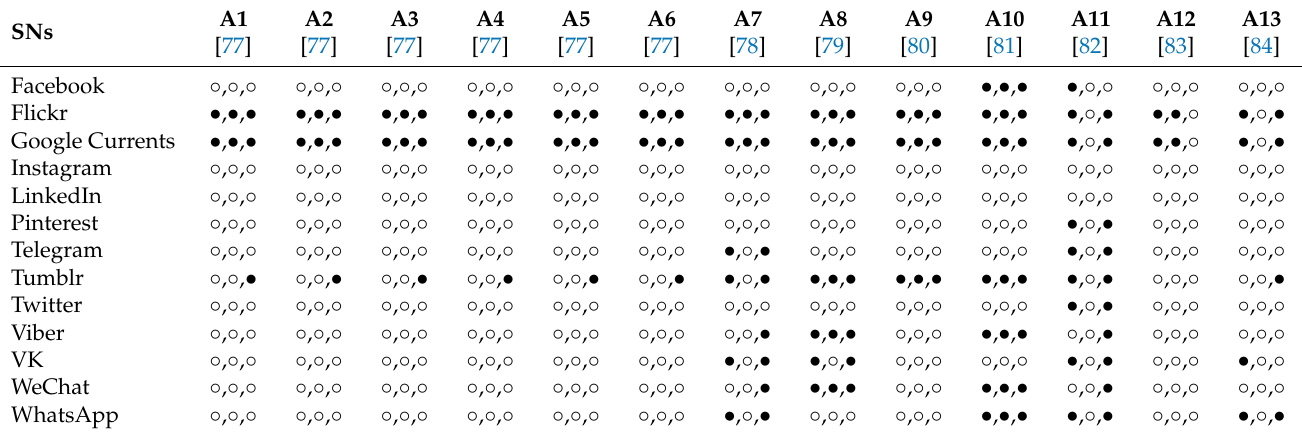
Table 3. The results of watermark extraction. For each algorithm, the failure/success of the extraction process is shown with a triplet of ◦ / • symbols following a sequence standard (see Column III in Table 1) of large (4128 × 2322) and small (640 × 480) resolution